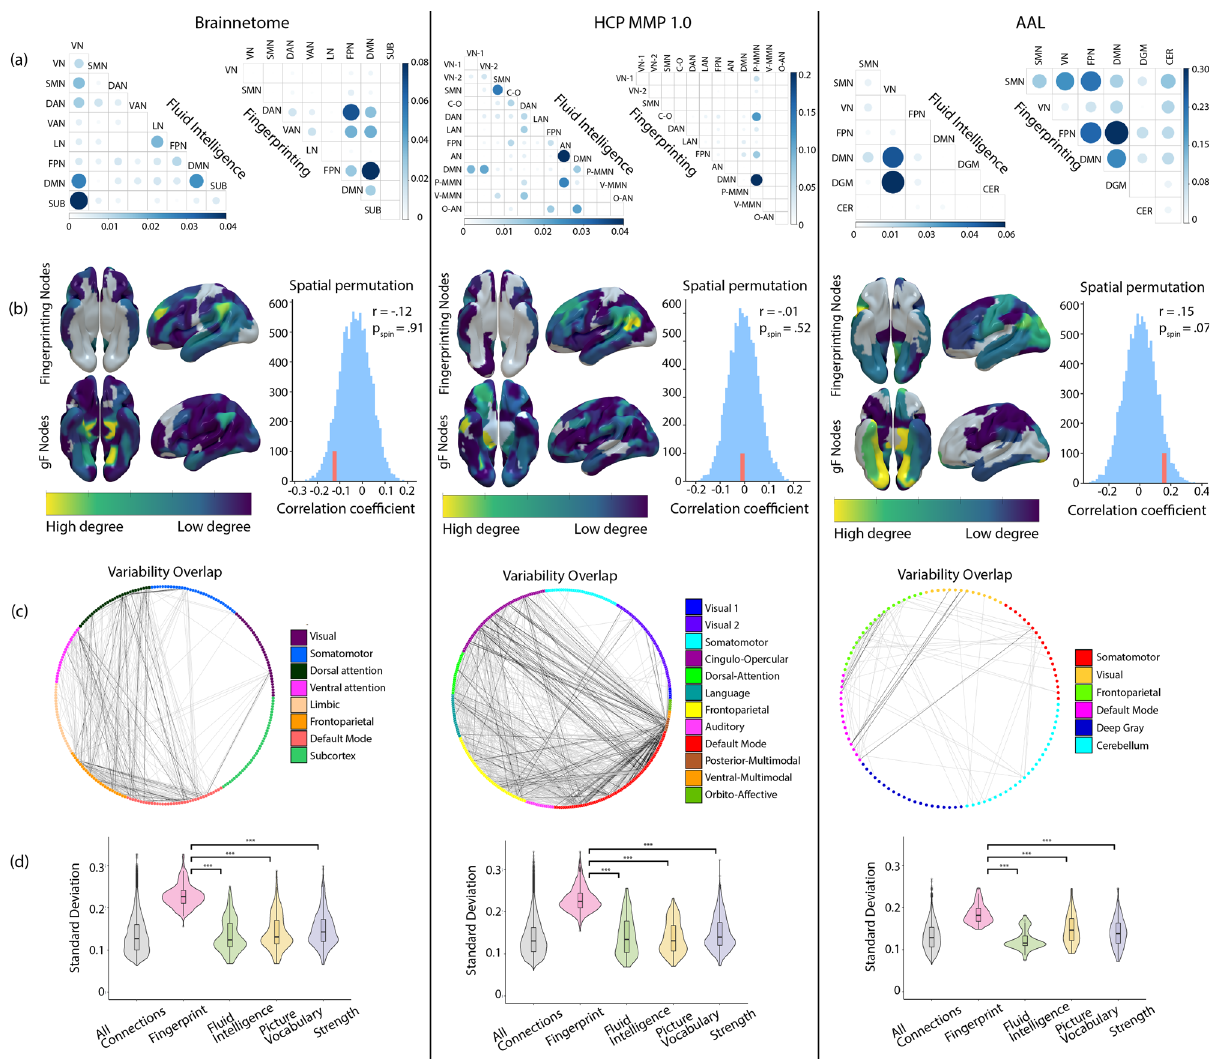
Fig. 5 Control analyses for different functional atlases. Results for Brainnetome, HCP MMP 1.0, and AAL atlases (left-to-right). From top to bottom, panels visualise a within and across-network connections, b spatial topology and spin permutation of nodes for fl uid intelligence and fi ngerprinting, c the overlap of individual edges between highly discriminatory and high-variability edges, and d the distribution of edge standard deviations over participants in fi ngerprinting and behavioural prediction. In the boxplots, the middle line signi fi es the median, the lower and upper hinges correspond to the fi rst and third quartiles and the upper and lower whisker represent 1.5 times the respective interquartile ranges. All points outside of whiskers are outliers. *** p < 0.001, FDR